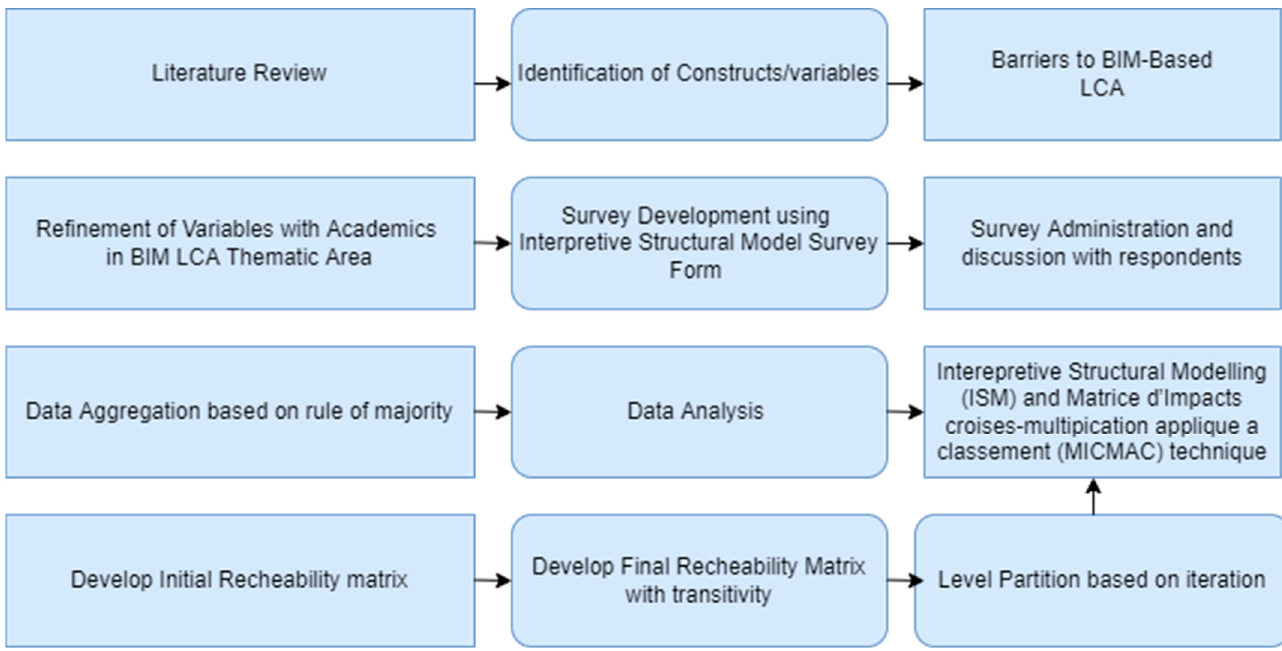
Figure 1. Research